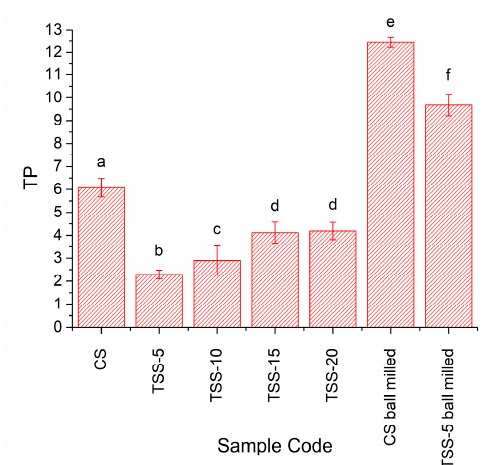
Figure 16. Translucency parameter of conventionally sintered and two-step sintered samples (T1 = 1400 °C, T2 = 1350 °C, t2 = 5–20